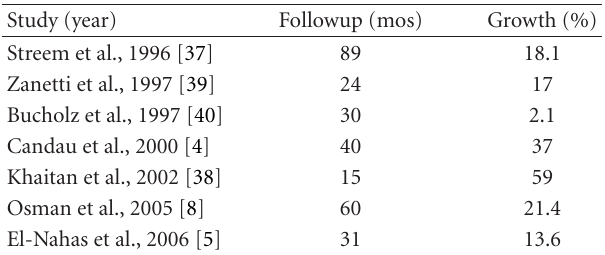
Table 1: Rate of regrowth of residual